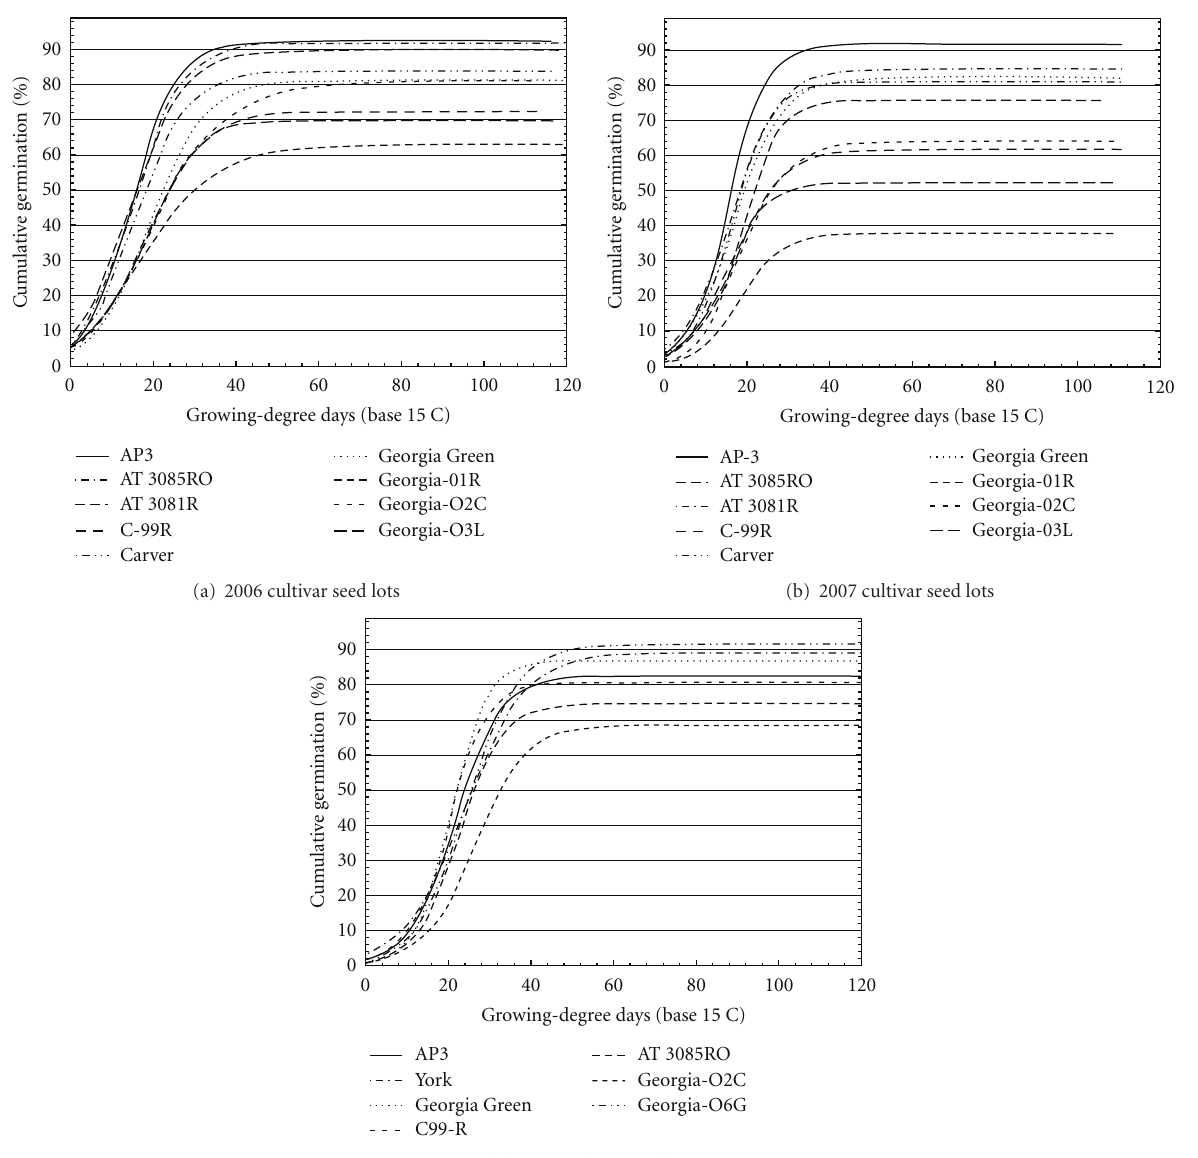
Figure 1: Cumulative germination patterns for Georgia runner-type peanut seed lots produced in 2006 (a), 2007 (b), and 2008 (c), based on nonlinear regression using growing-degree day (GDD) accumulation with a base temperature 15 ◦ C. To calculate the regression equation for the respective seed lot, the parameter estimates shown in Table 1 for the equation Y = a/ 1+[(( a − b 1) /b 1) ∗ e ( − b 2 x ) ] were used. Germination was measured on a thermal